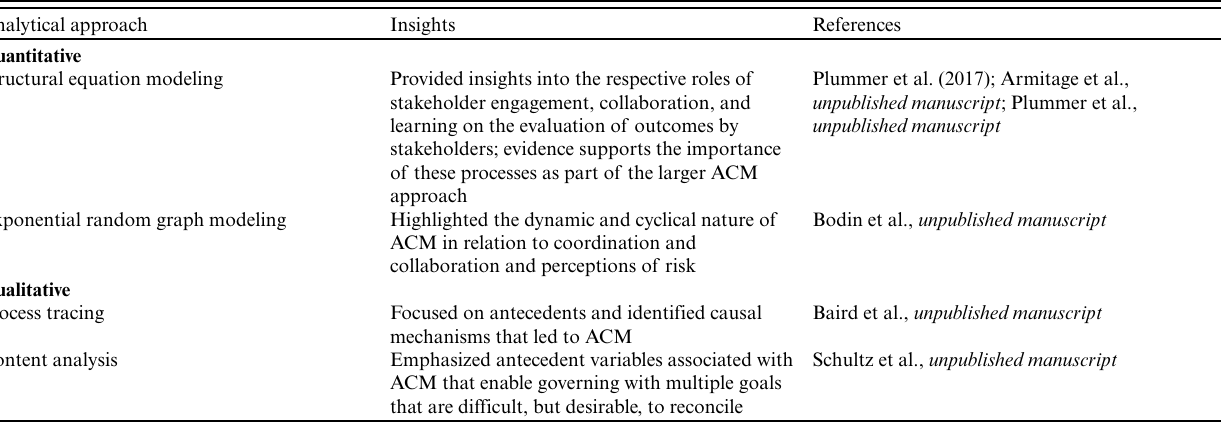
Table 2 . Insights from analyses undertaken using the diagnostic framework for adaptive comanagement